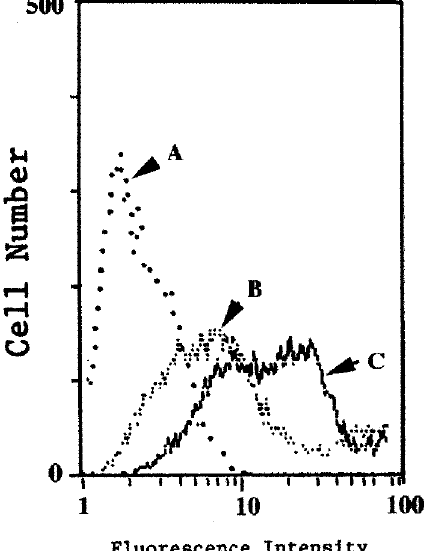
FIG. 2. Single-parameter fluorescence histograms (one of three experiments) of: (A) unstained cells, (B) cells stained with non-immune serum, and (C) cells stained with anti- bodies against IL-1R type I. There was a significant shift in fluorescence ( P <0.001), indicating the presence of the recep- tor on the epithelial